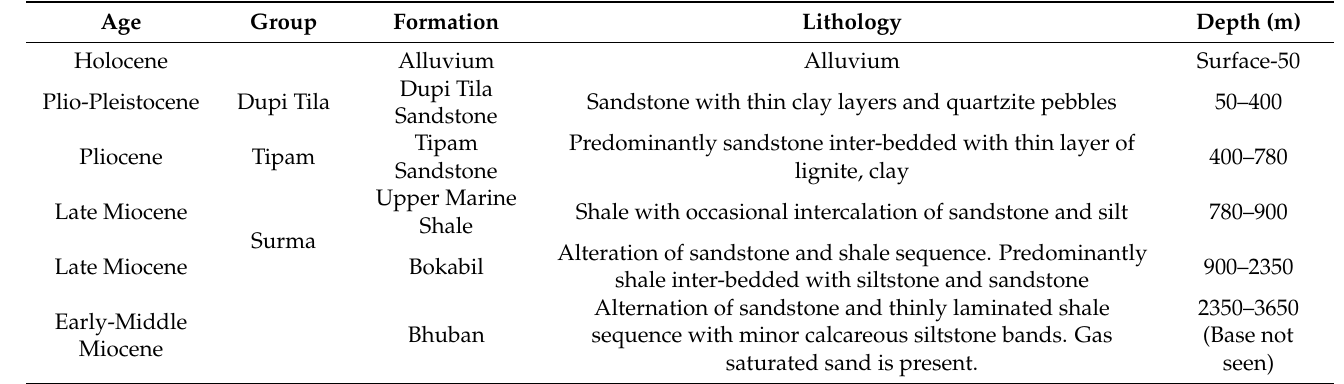
Table 1. Litho-stratigraphic successions of the Srikail structure (modified after